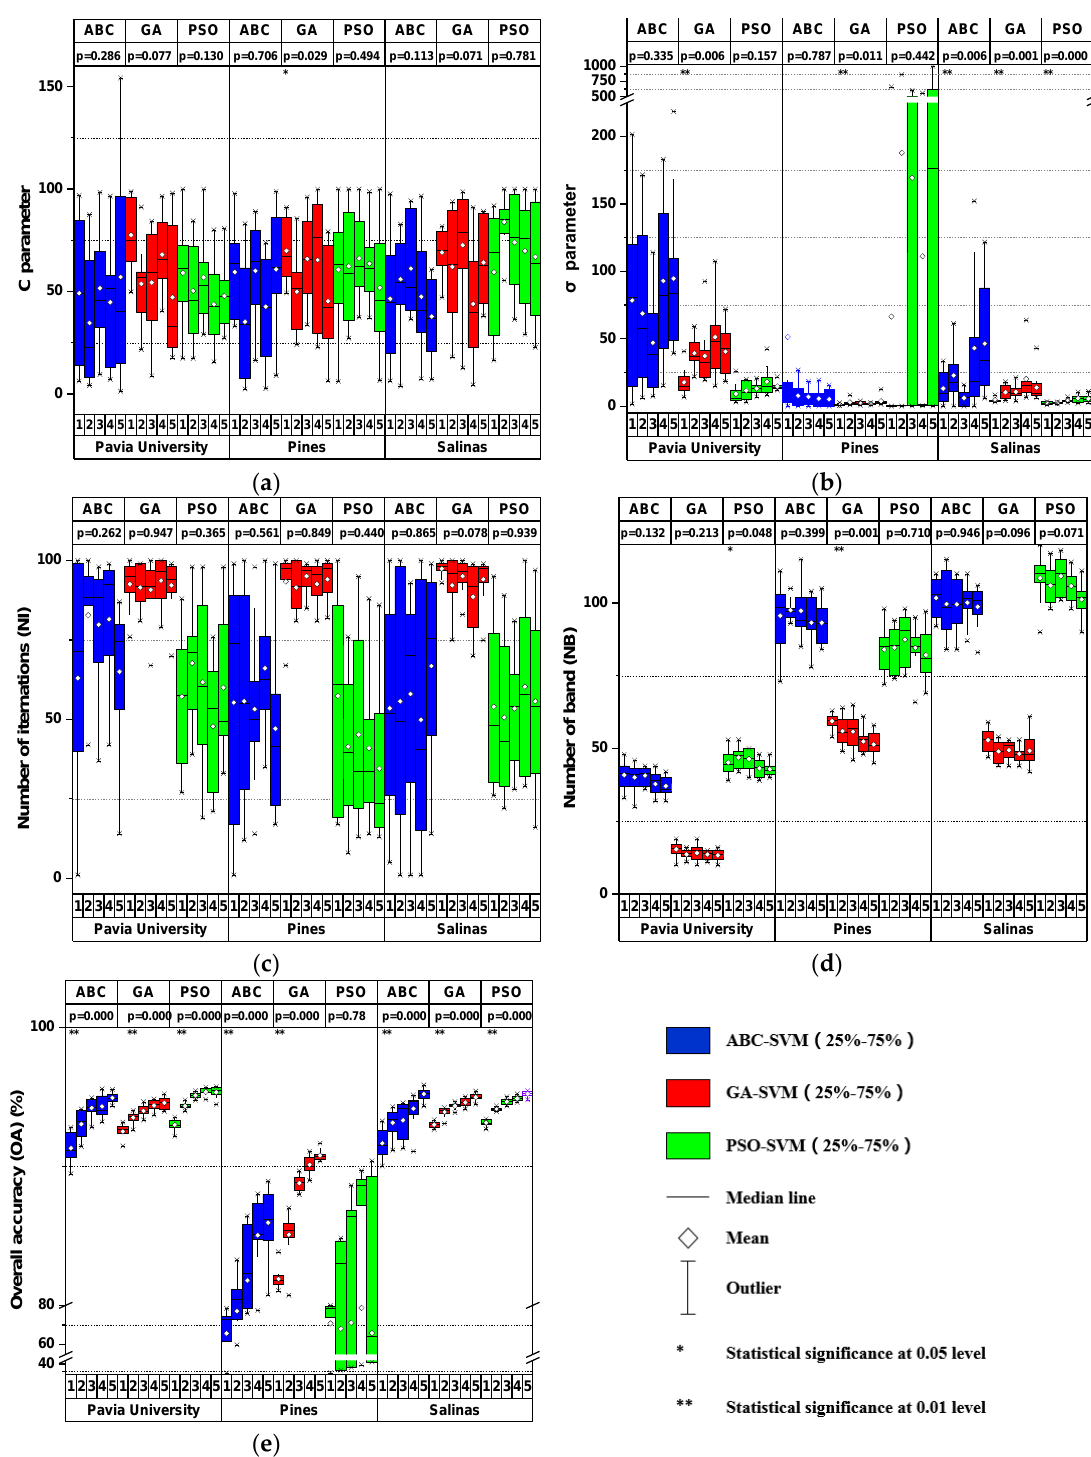
Figure 8. The impact of sample size on each GI algorithm’s performance including ( a ) C parameter, ( b ) σ parameter, ( c ) number of iteration, ( d ) number of band and ( e ) overall accuracy. (1, 2, 3, 4, and 5 refer to sampling ratios of 5%, 10%, 15%, 20%, and 25%, respectively)